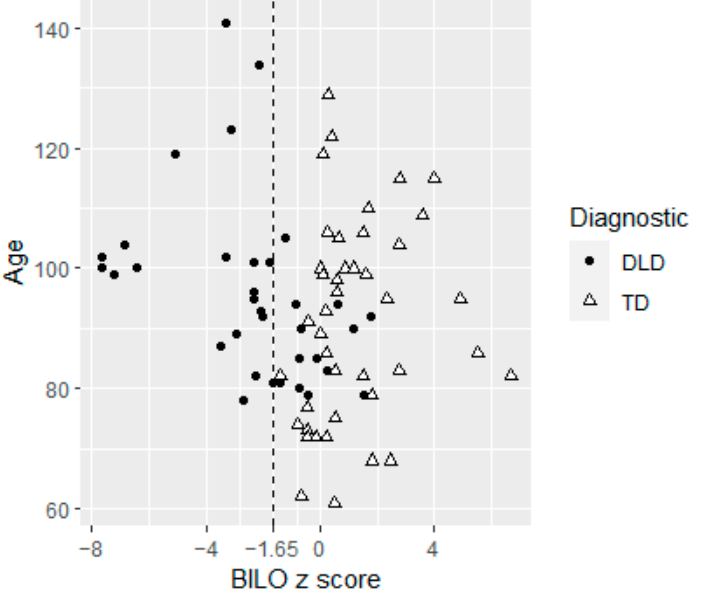
Figure 2. Scatterplot of z scores obtained on a standardized morphosyntactic test (BILO) by age, separating children with TD and those with DLD, based on the diagnosis performed by certified SLTs.